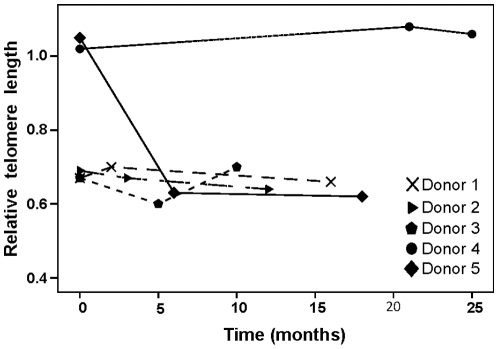
RTL values of subsequent blood samples obtained from five blood donors.Donor 5 demonstrated a marked change (decrease) in RTL between the first and second blood draw, which was not seen in any other donor.